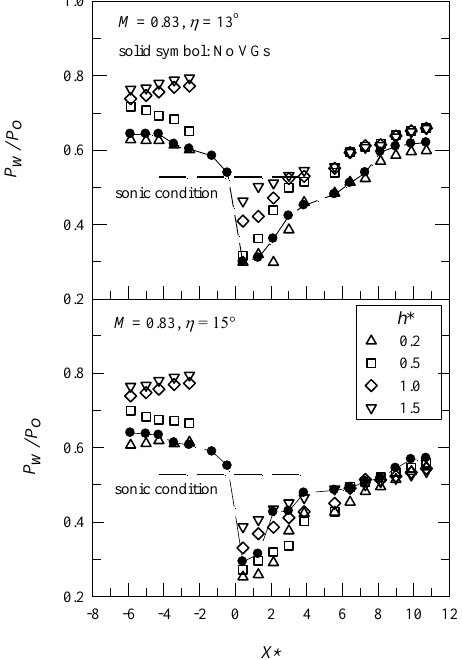
Figure 4. Mean surface pressure distributions for M = 0.83.